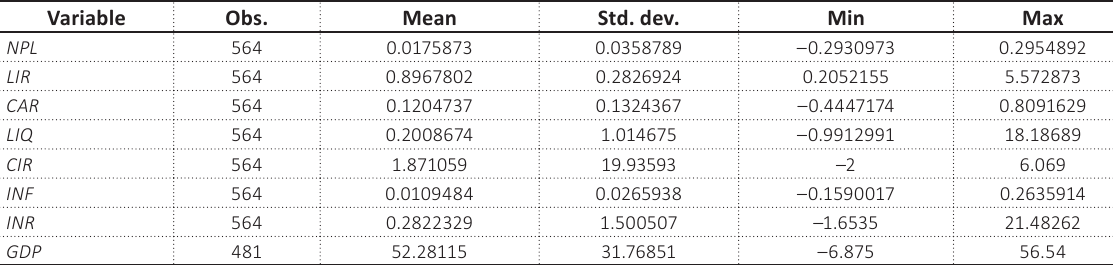
Table 3. Summary